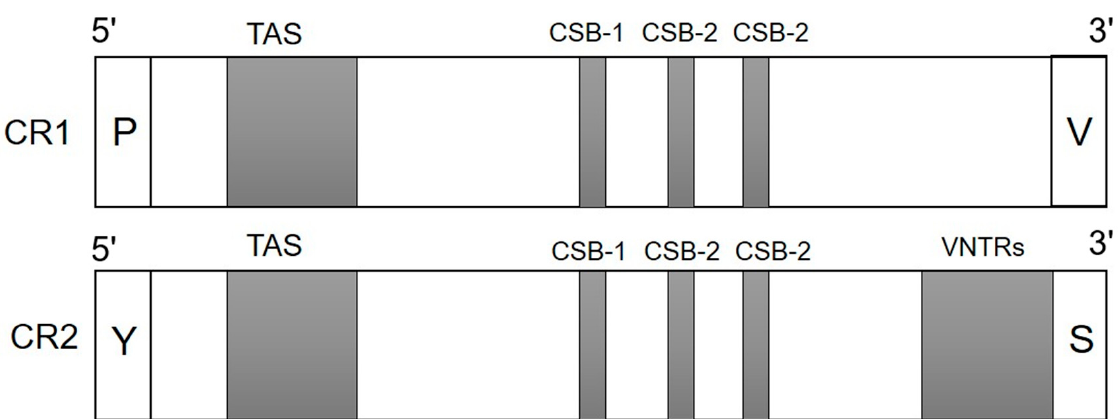
Figure 1. Structures of duplicate control regions (CRs) in all individuals of Varanus salvator macromaculatus (Deraniyagala 1944 [16]) in this study. Two functional regions, TAS and CSB, were detected in both the CRs of all individuals. The core sequences of these regions were found to be identical in both CR1 and CR2. Variable numbers of tandem repeats were detected only in CR2.